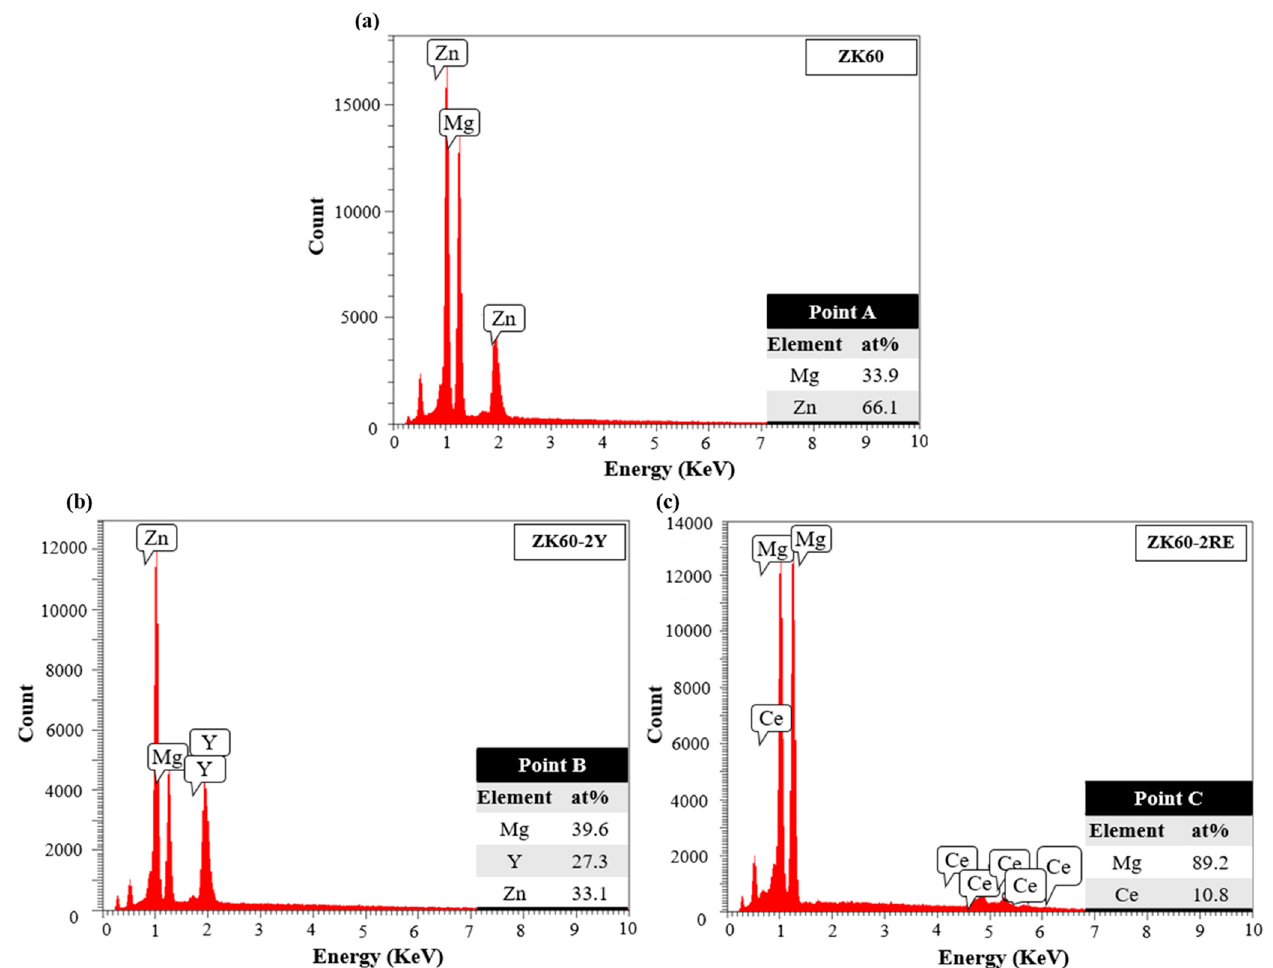
Figure 2. EDS spectra corresponding to ( a ) point A in Figure 1a, ( b ) point B in Figure 1b, and ( c ) point C in Figure 1c.